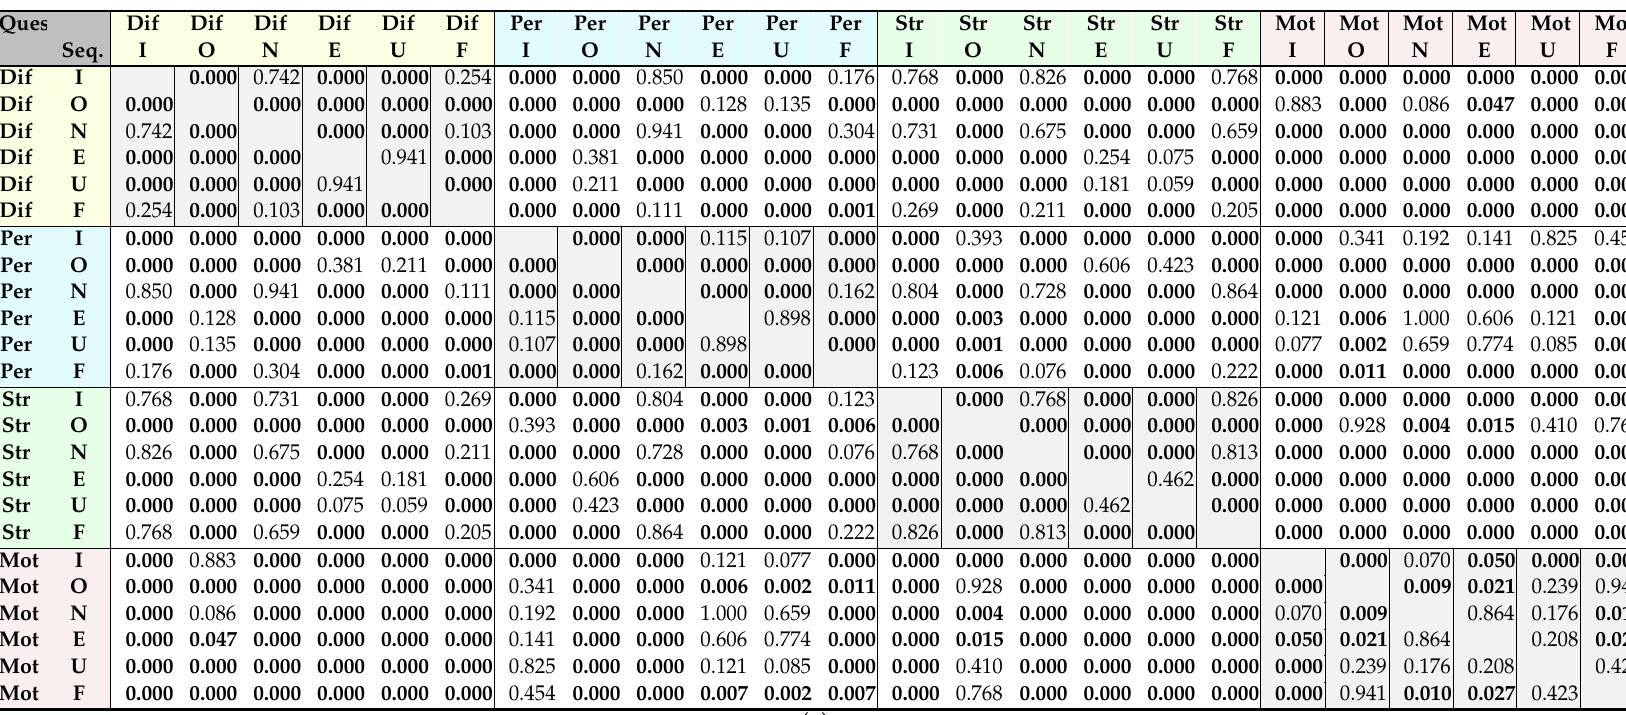
Table A2. ( a ) Newman-Keuls post-hoc corrections for the Direct Questions Quest. (Dif = “Di ffi culty”; Per = “Performance”; Str = “Stress”; Mot = “Motivation”) and the sequences Seq. (I = Interest , O = Overload , N = Normal , E = Easy , U = Underload , F = Frustration ) for Group A. Significant e ff ects are marked bold ( p < 0.05). ( b ) Newman-Keuls post-hoc corrections for the Direct Questions Quest. (Dif = “Di ffi culty”; Per = “Performance”; Str = “Stress”; Mot = “Motivation”) and the sequences Seq. (I = Interest , O = Overload , N = Normal , E = Easy , U = Underload , F = Frustration ) for Group A + Group B1. Significant e ff ects are marked bold ( p < 0.05).